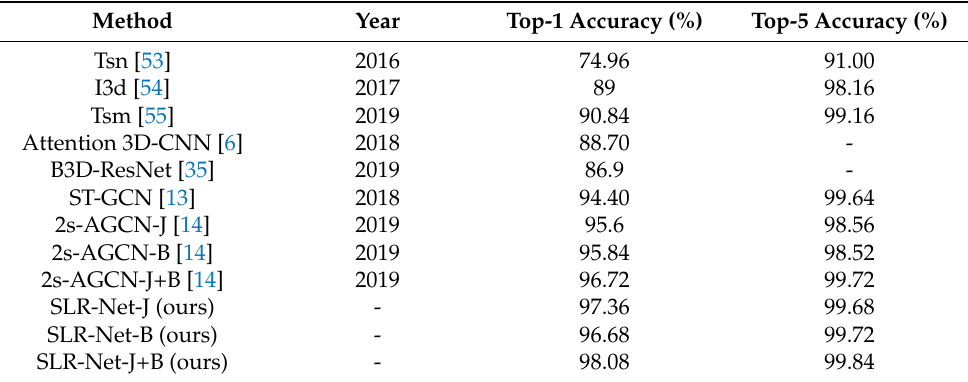
Table 11. The accuracy comparisons with state-of-the-art methods on the CSL-500 dataset.